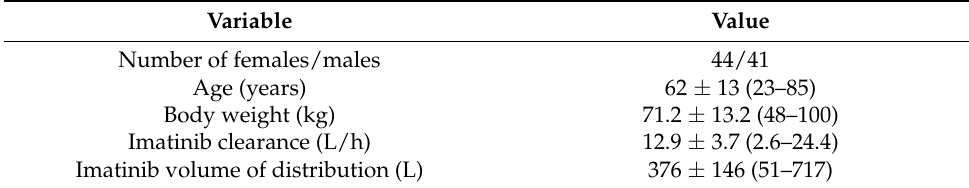
Table 3. Characteristics of the 85 patients with